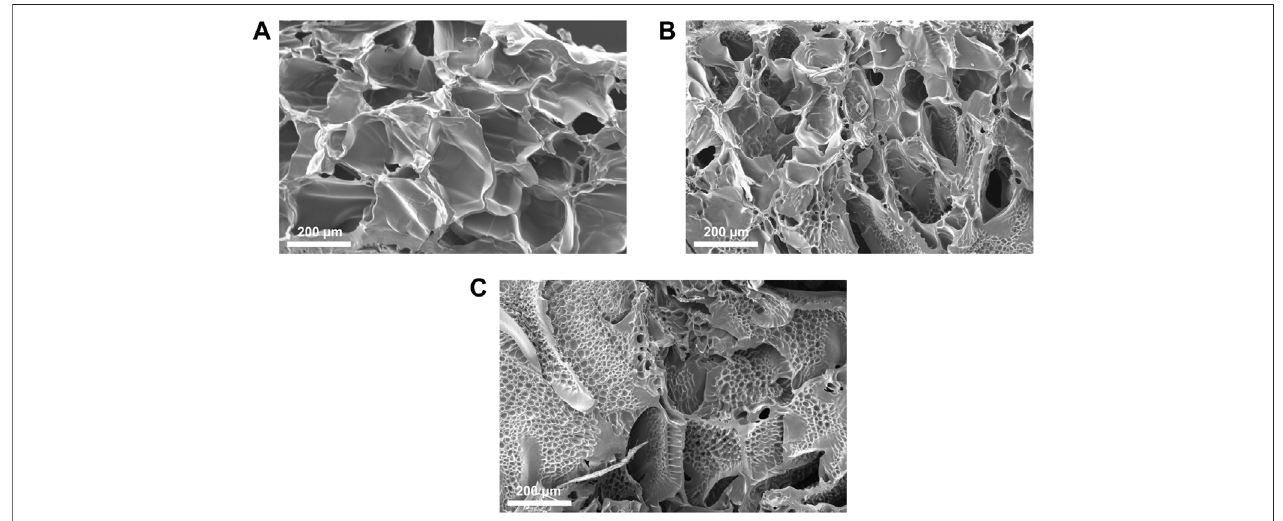
FIGURE 4 | Cross-sectional SEM images of lyophilized (A) P1G1, (B) P1.5G1 and (C) P2G1 pristine hydrogels (scale bars = 200 µm).